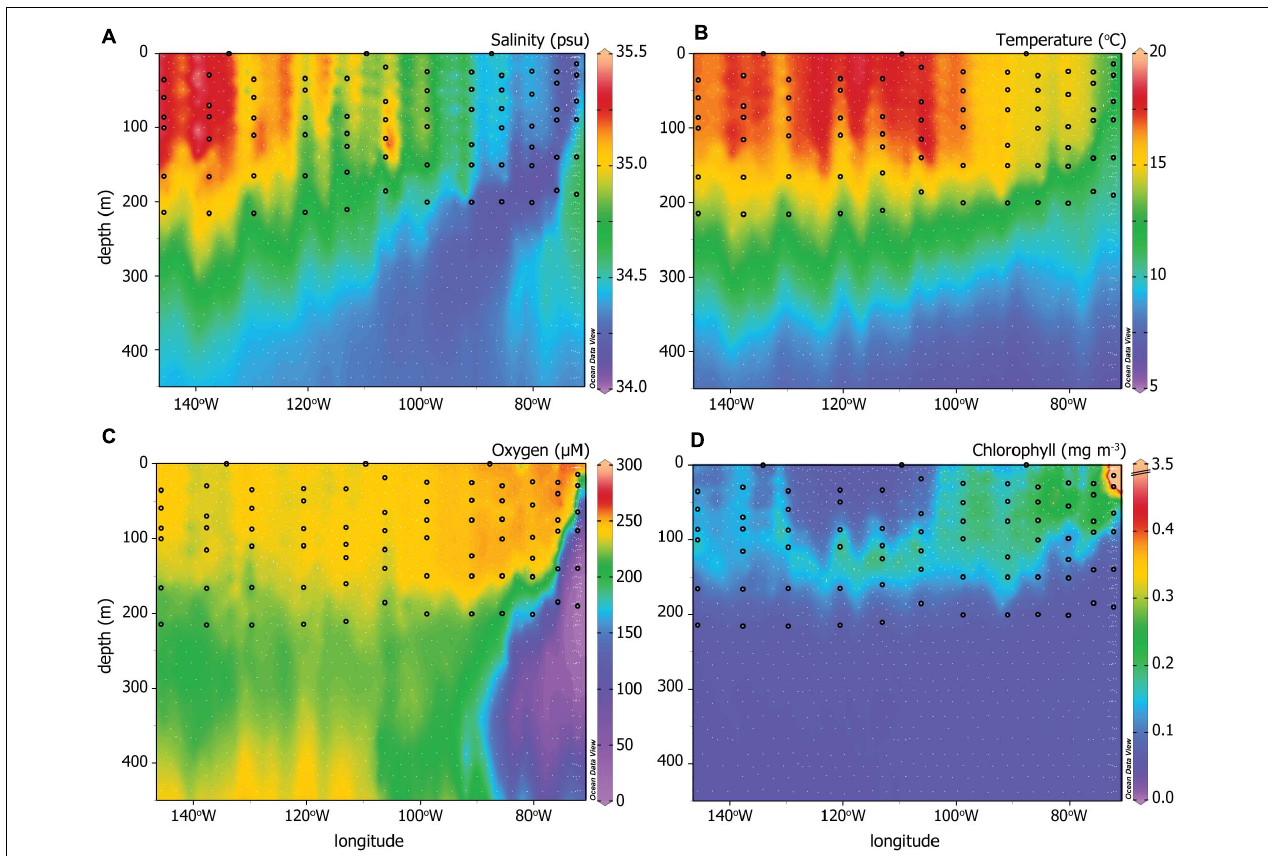
FIGURE 2 | CTD data for (A) Salinity, (B) temperature, (C) oxygen, and (D) chlorophyll across the P06E transect. White dots indicate all sampling depths and locations for the U.S. GO-SHIP P06E data plotted here (Swift et al., 2019). The black circles indicate the sampling depths and locations that correspond to the PATP and biomass data from Figure 1 . Note the extended depth of the y -axis is intended to visualize the different water masses more effectively than the sampled depths depicted in Figures 1 , 3